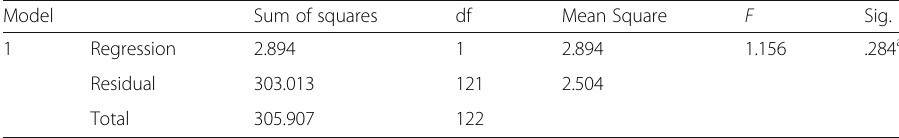
Table 14 ANOVA Model Sum of squares df Mean Square F